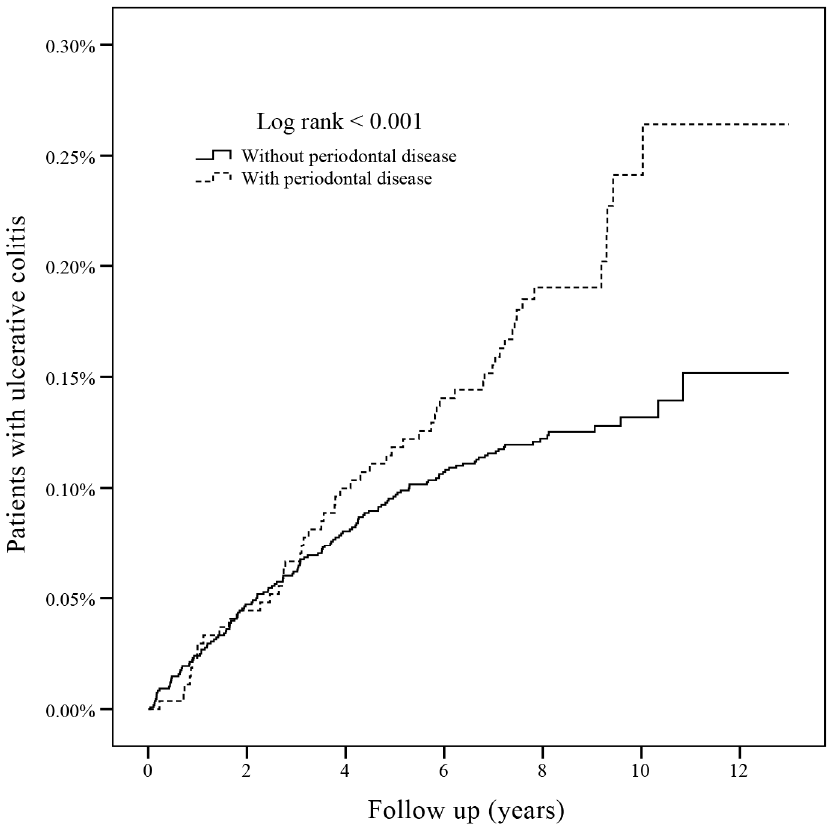
Figure 2. The Kaplan–Meier survival curve of ulcerative colitis in both groups. Table 3. Independent predictors of Ulcerative colitis identified by Cox regression analysis.